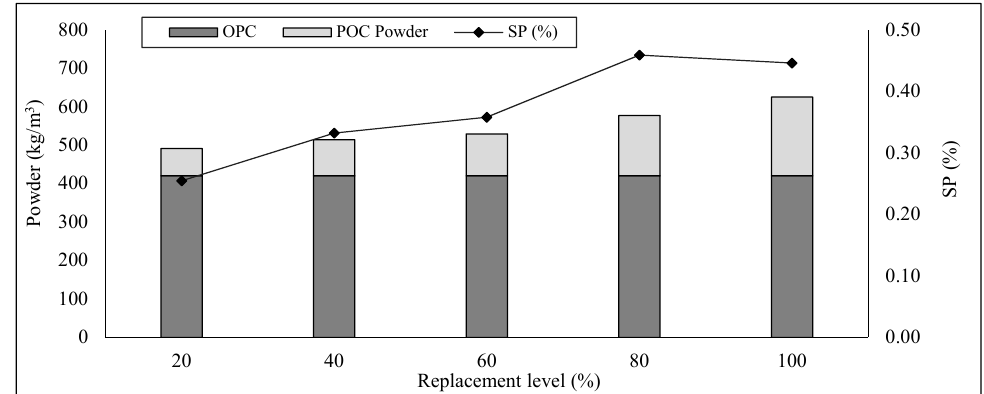
Figure 7. POCP and SP dosage for each replacement level.